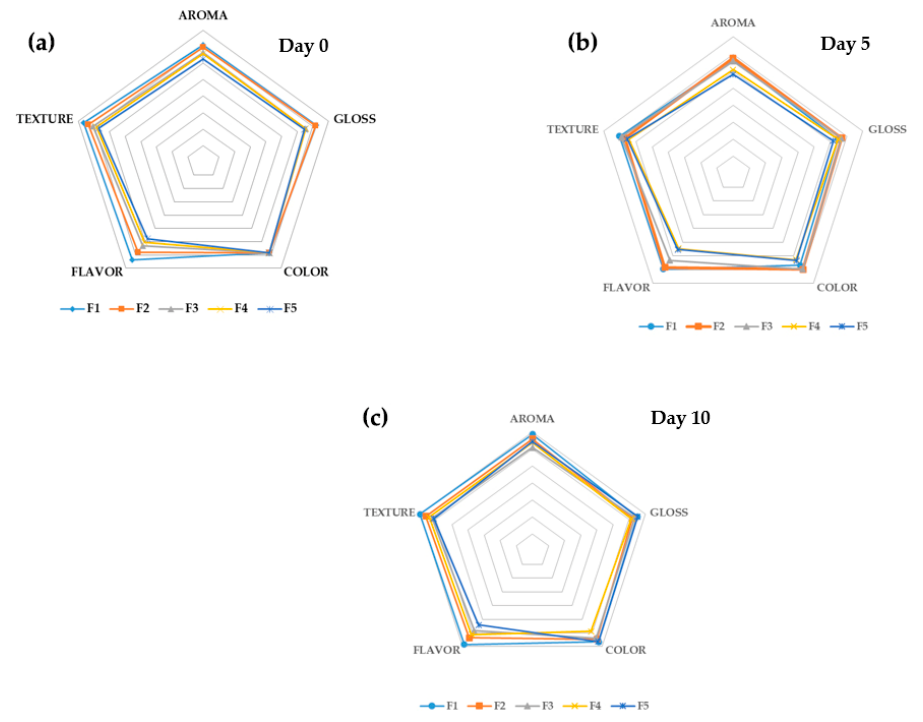
Figure 6. The hedonistic scale of the sensory analysis on days 0 ( a ), 5 ( b ), and 10 ( c